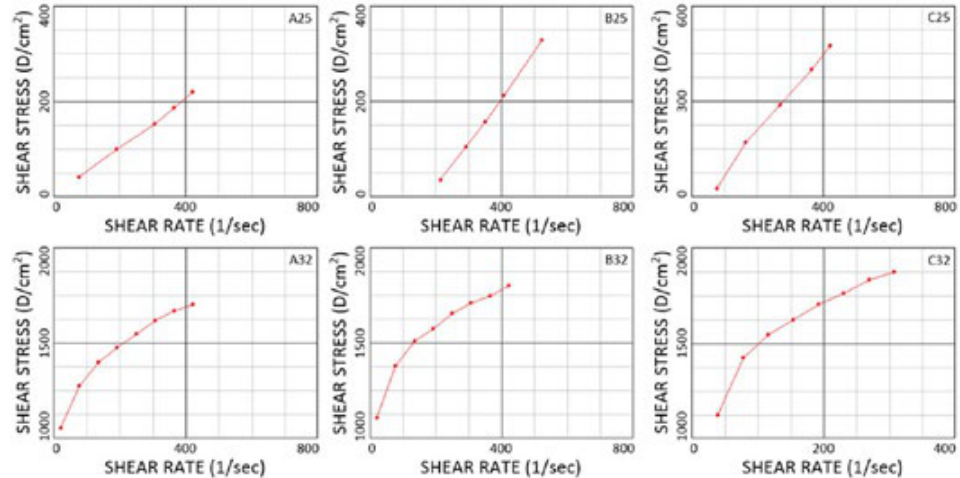
FIGURE 4 - Effect of temperature on rheological behavior of formulations. (A25 F16, 25 °C; B25 P16, 25 °C; C25 FH1405, 25 °C; A32 F16, 32 °C; B32 P16, 32 °C; C32 FH1405, 32